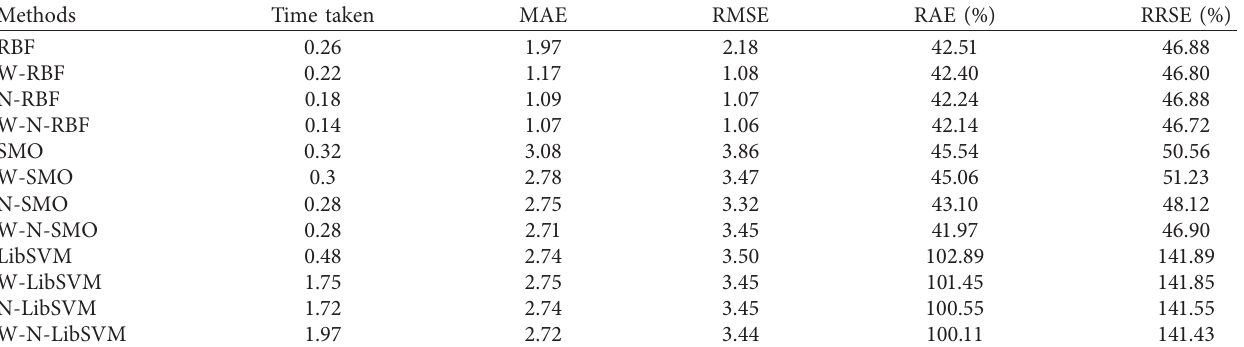
Figure 2: Comparison between actual and forecasted time series for Delhi. (a) Comparison plot between forecasted and actual data for maximum temperature (RBF). (b) Comparison plot between forecasted and actual data for maximum temperature (SMO). (c) Comparison plot between forecasted and actual data for maximum temperature (LibSVM). (d) Comparison plot between forecasted and actual data for minimum temperature (RBF). (e) Comparison plot between forecasted and actual data for minimum temperature (SMO). (f) Comparison plot between forecasted and actual data for minimum temperature (LibSVM). (g) Comparison plot between forecasted and actual data for wind speed (RBF). (h) Comparison plot between forecasted and actual data for wind speed (SMO). (i) Comparison plot between forecasted and actual data for wind speed (LibSVM). (j) Comparison plot between forecasted and actual data for evaporation (RBF). (k) Comparison plot between forecasted and actual data for evaporation (SMO). (l) Comparison plot between forecasted and actual data for evaporation (LibSVM). Table 2: Comparison of errors and time taken for maximum temperature, Delhi.